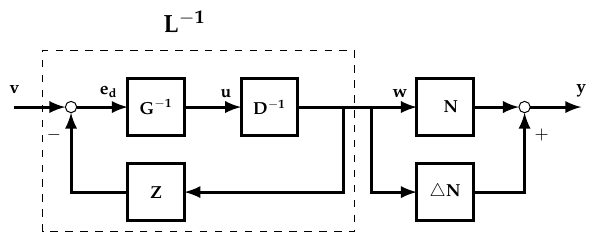
Figure 4. Decoupling structure of the MIMO